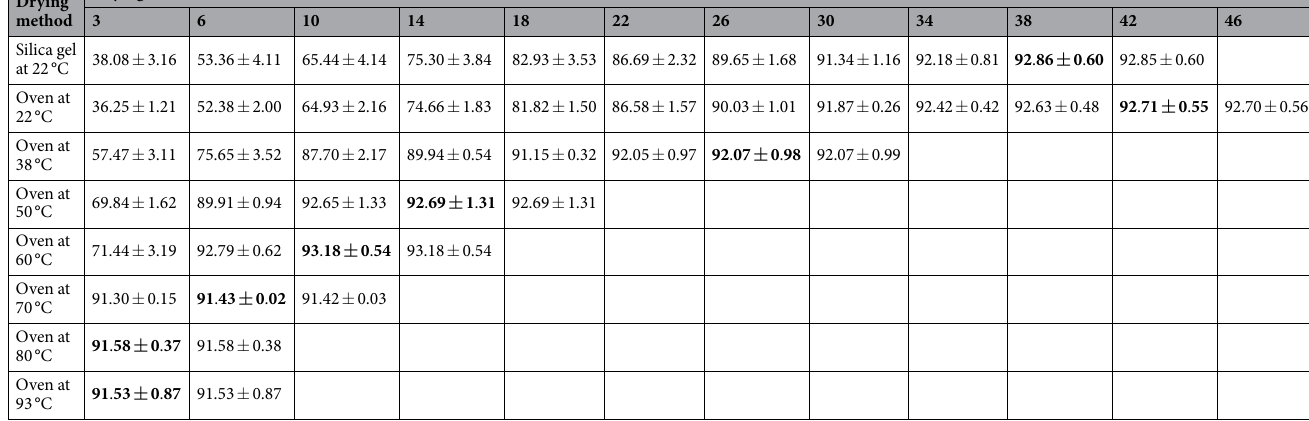
Table 2. The percentage of weight reduction due to water loss during drying of Agaricus bisporus fruiting bodies by different drying methods and at different drying times * (mean ± SD, n = 3). * The bold values in the table represent the final, constant water loss ratio for each drying method.